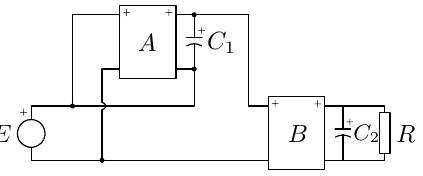
Figure 1. Noncascading I–IIA structure based on the R 2 P 2 concept.